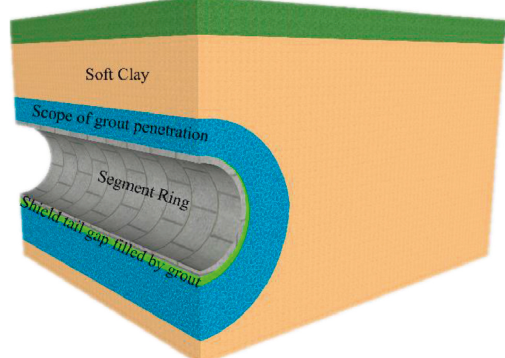
Figure 1: The most disadvantageous form of shield tail gap.